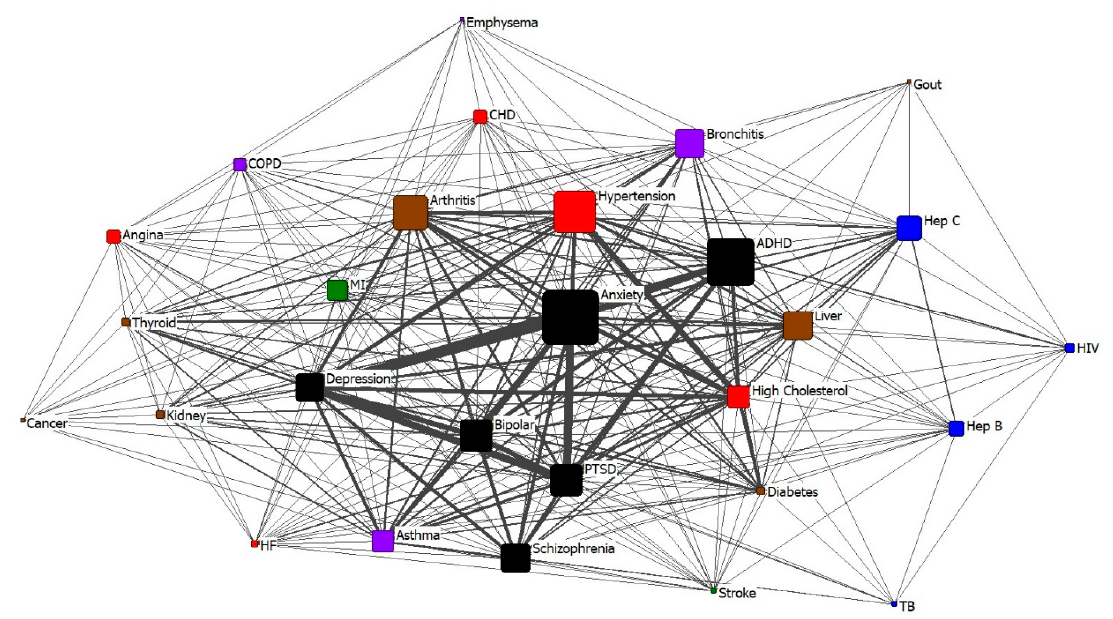
Figure 1. Network Relationships between Self-Reported Health Conditions in Jail Sample. Morbidity Type Legend. 1= mental health; black. 2 = infectious disease; blue. 3 = organs and cancer; brown. 4 = lungs/pulmonary; purple. 5 = acute cardiac; green. 6 = heart and vascular; red.